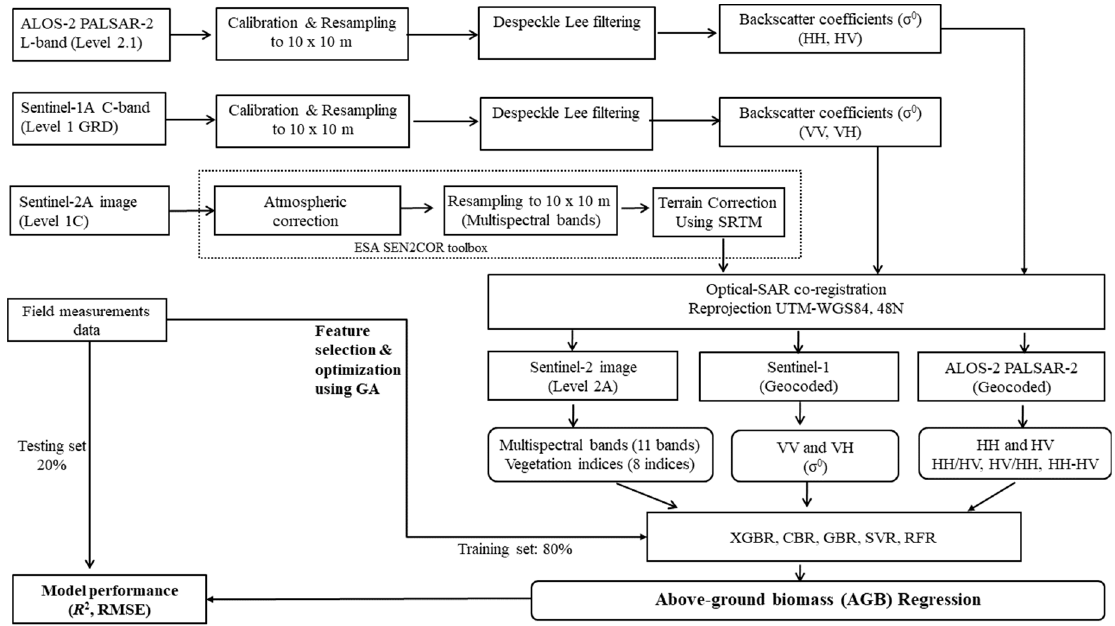
Figure 3. Flowchart for processing the satellite images and generating mangrove AGB predictive models using the ML techniques covered in this study.